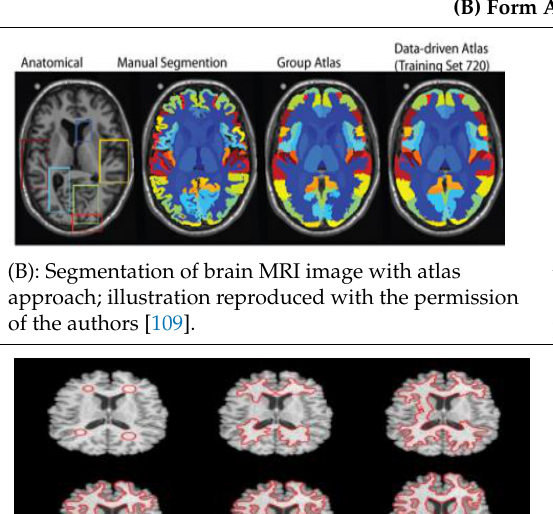
Example of brain tumour segmentation of MRI image using genetic algorithms (GA): (left) Original MRI, (right) the result of segmentation; illustration reproduced with the permission of Taylor & Francis Ltd [50].